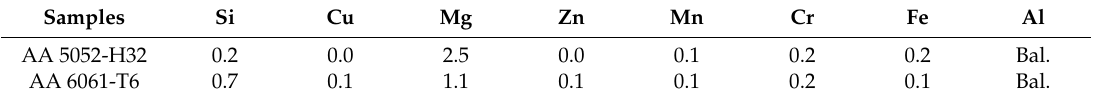
Table 1. Elemental compositions of weldedbase metals (wt. %).